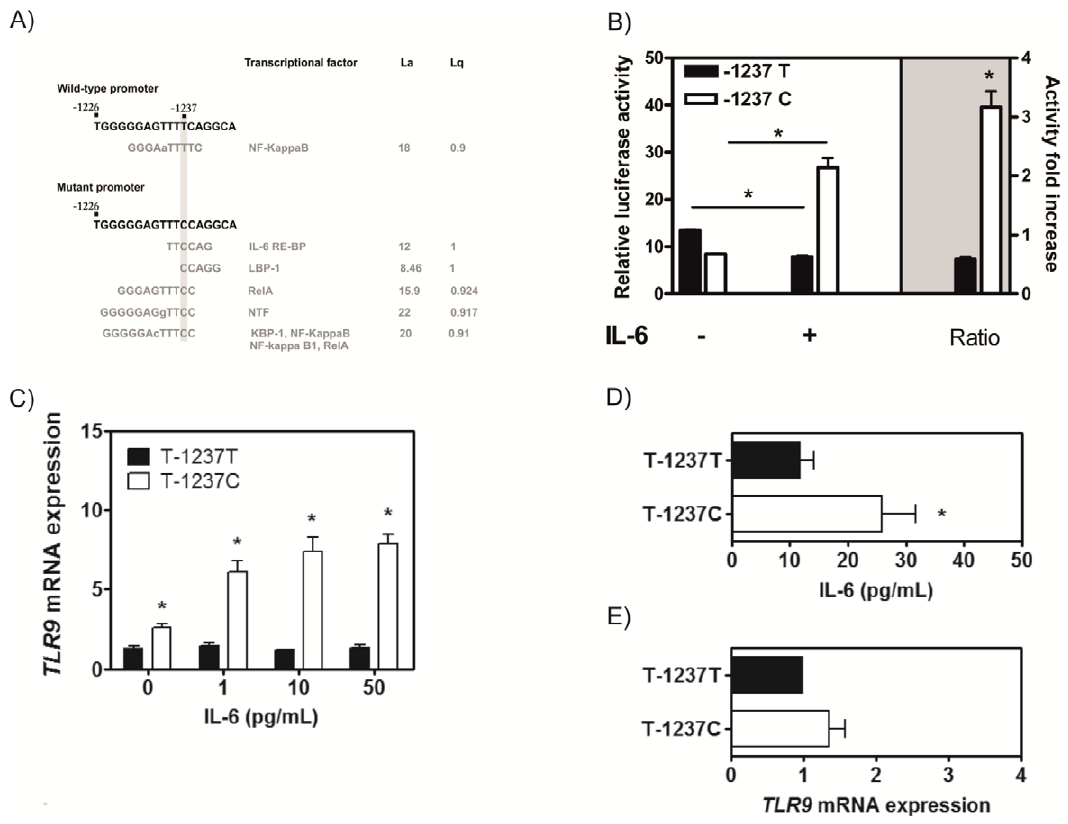
Figure 1. IL-6 increases the activity of the TLR9 promoter carrying the C allele of rs5743836. (A) In silico analysis of the fragment of the TLR9 promoter containing the T/C substitution using the TESS interface. L a , log-likelihood score, L q , a measure of the goodness-of-fit of the DNA sequence to the consensus binding motif. (B) Luciferase reporter assay of Raji B cells transfected with plasmid vectors containing the luciferase gene under the control of a 3.2 kb fragment of the promoter sequence carrying the T or C allele. After transfection, cells were left untreated or stimulated with IL-6 (n=3). (C) IL-6 dose-dependent stimulation of either TT (n=27) or TC (n=25) PBMCs. Cells were left untreated or stimulated with increasing doses of recombinant IL-6. TLR9 mRNA expression levels were determined by real-time PCR. (D) IL-6 secretion by of either TT (n=21) or TC (n=17) PBMCs. IL-6 in untreated cells was quantified by ELISA. (E) TLR9 expression in TT (n=21) or TC (n=17) PBMCs in IL-6-neutralizing conditions. Cells were cultured with an anti-IL-6 antibody and TLR9 mRNA expression was determined by real-time PCR. Results shown are the mean 6